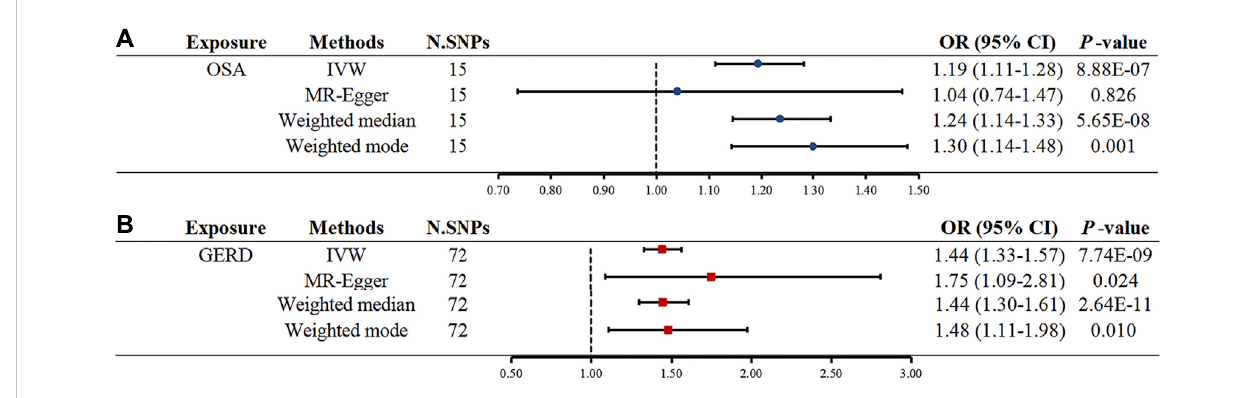
FIGURE 2 Two-sampleMRestimatesresultsofcausalassociationsbetweenOSAandGERD. (A) CausalestimatesresultforOSAonGERD. (B) Causalestimates resultforGERDonOSA.Abbreviation: MR,Mendelianrandomization;OSA,obstructivesleepapnea;GERD,gastroesophagealre fl uxdisease;IVW,inverse varianceweighted;N.SNPsisthenumberofSNPsafteroutliersremoved;SNPs,singlenucleotidepolymorphisms;OR,oddsratio;CI,con fi denceinterval.